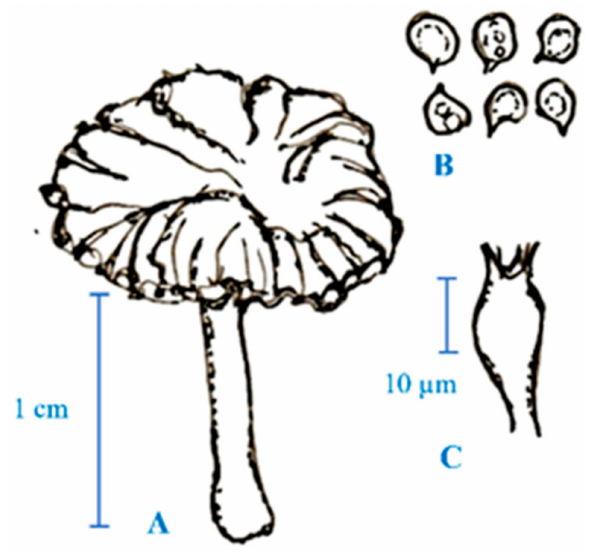
Figure 3. Pluteus parvicarpus . ( A ) Carpophore; ( B ) basidiospores; ( C ) basidium. Gymnopilus contains over 200 species worldwide and is characterized by dry, medium to large fruiting bodies that range in color from rusty orange to yellow with well-developed veils (Figure 4). The spore is verrucose to rugulose ornamentation but lacks germinal pores of the basidiospores, and no germ pore or dextrinoid walls, while spore prints are rusty brown in color [51,52]. So far, 16 species have been found to contain psilocybin and psilocin are commonly found including G. cyanopalmicola , G. palmicola , G. igniculus , G. validipes , G. aeruginosus , G. braendlei , G. intermedius , G. lateritius , G. liquiritiae , G. luteoviridis , G. luteus , G. purpuratus , G. sapineus , G. spectabilis , G. subpurpuratus , G. validipes , and G. viridans . Gymnopilus can grow on wood or grassy areas with decomposing wood [51,52].